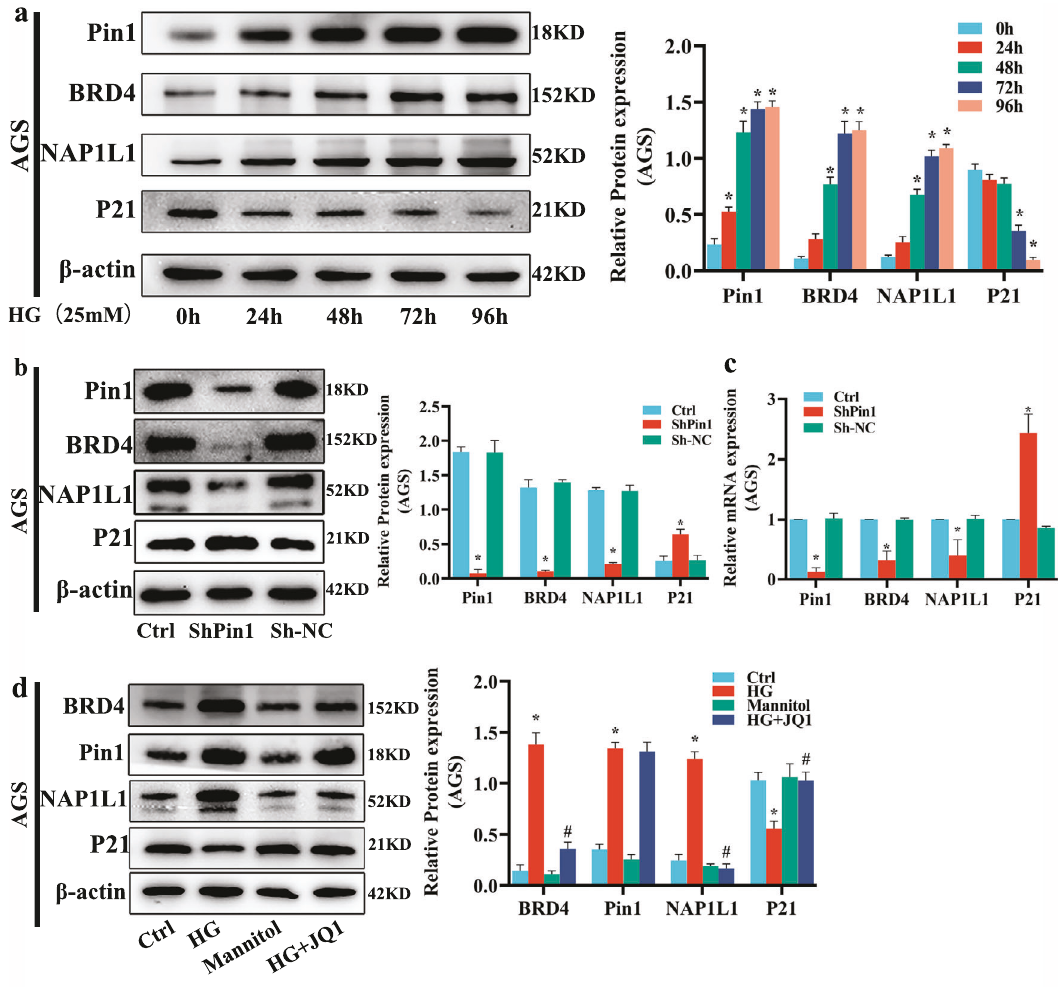
Fig. 4 Pin1/BRD4 axis regulates P21 by targeting NAP1L1. a AGS cells were treated with HG for 24, 48, 72, and 96 h. Pin1, BRD4, NAP1L1 and P21 protein expression was detected by WB; β -actin represents the loading control. Values are mean ± SEM; * P < 0.05 vs. 0 h. b , c AGS was infected with lentivirus vector of ShPin1 or Sh-NC and incubated with HG for 72 h. Subsequently, Pin1, BRD4, NAP1L1, and P21 protein or mRNA expression were detected via WB and qRT-PCR; β -actin represents the loading control. Values are mean ± SEM; * P < 0.05 vs . Ctrl. d AGS was pretreated with JQ1 (10 − 6 M) for 1 h and incubated with HG for 72 h. Pin1, BRD4, NAP1L1, and P21 protein expression were detected by WB, β -actin represents the loading control. Values are mean ± SEM; * P < 0.05 vs. Ctrl; # P < 0.05 vs. HG. All the experiments were performed 3